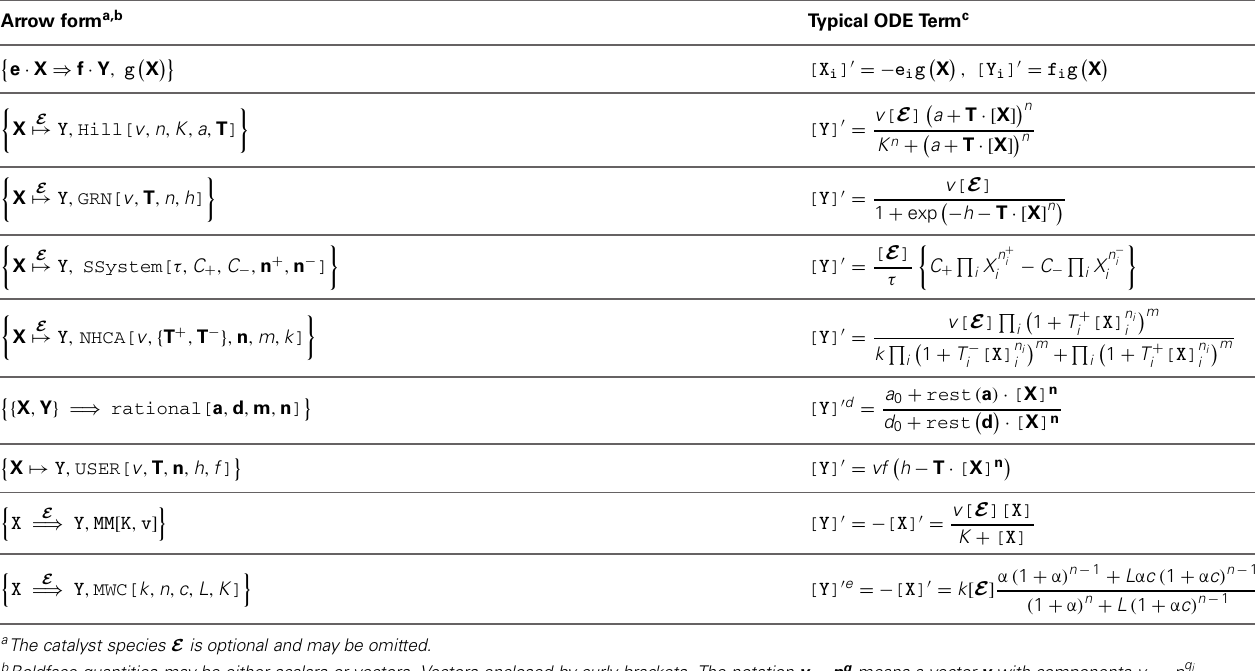
Table 2 | Cellerator user defined, regulatory, and enzymatic arrow forms. Arrow form a,b Typical ODE Term c